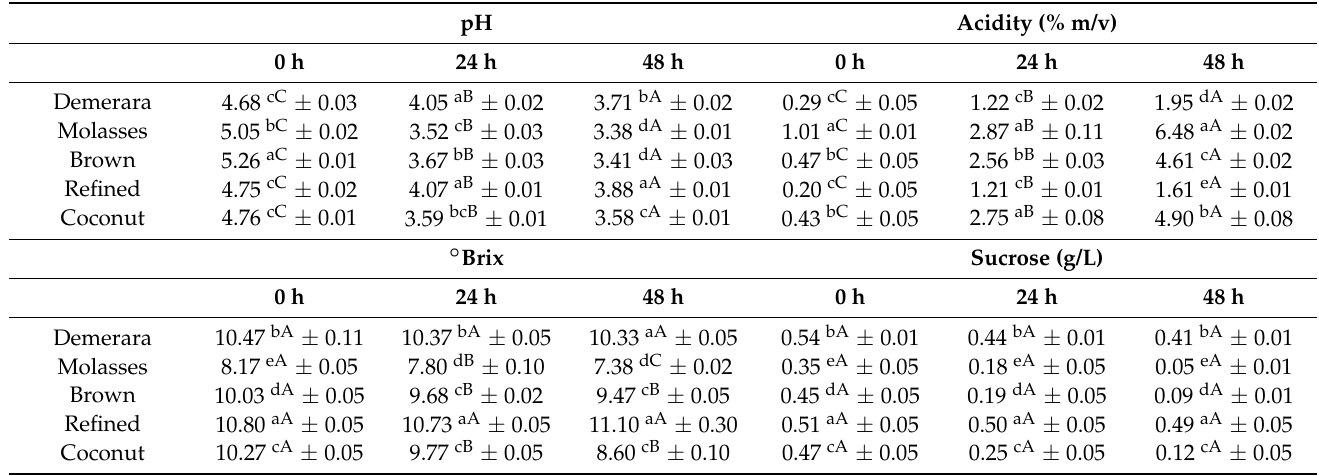
Table 1. Physicochemical analyses performed on water kefir beverages with different fermenta- tive